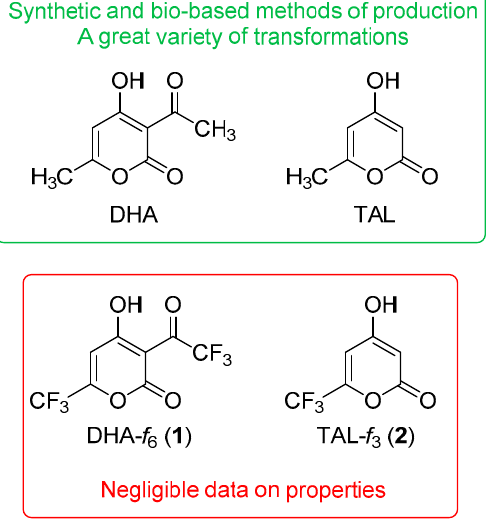
Figure 1. Structure of DHA, TAL, DHA- f 6 , and TAL- f 3 .